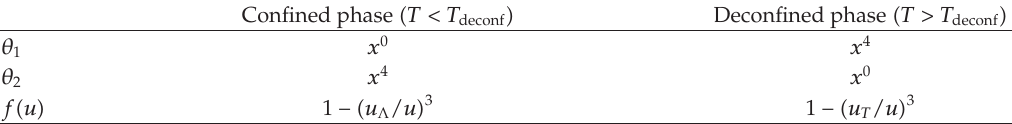
Table 3: Geometric assignment of the compactified bulk coordinates in the Sakai-Sugimoto